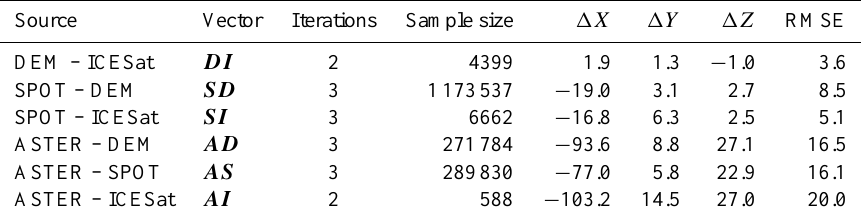
Table 5. Shift vectors between the 4 data types in Svalbard as tested in Sect. 6.1. 1X , 1Y and 1Z are the 3 components of the full co-registration adjustment vector between the datasets in meters and the RMSE is calculated after correction.